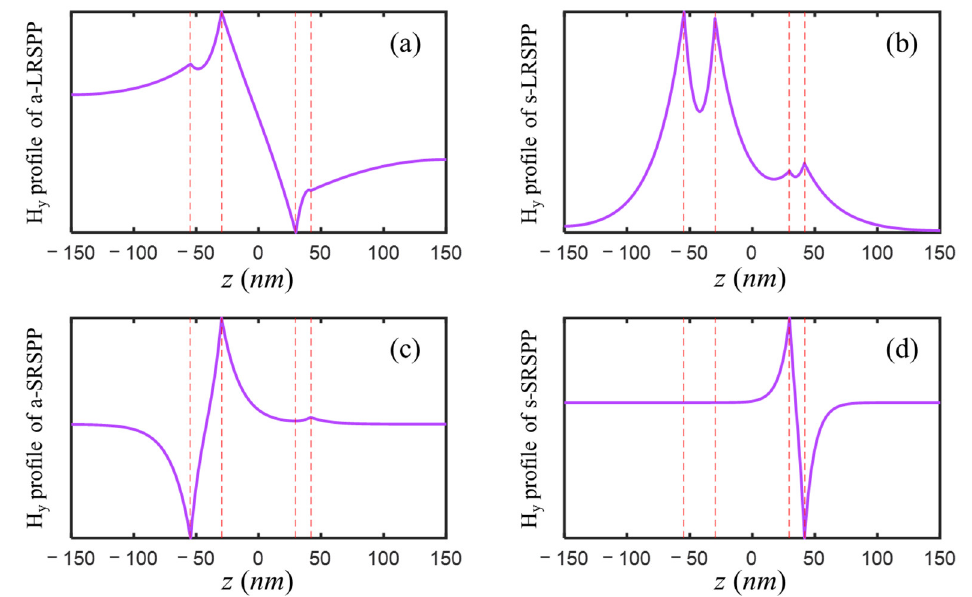
Figure 3. H y profile of ( a ) a-LRSPP, ( b ) s-LRSPP, ( c ) a-SRSPP, and ( d ) s-SRSPP mode of five-layer